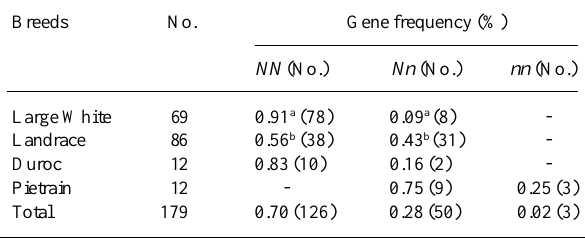
Table I - Frequencies of the hal gene in different breeds of pigs. Breeds